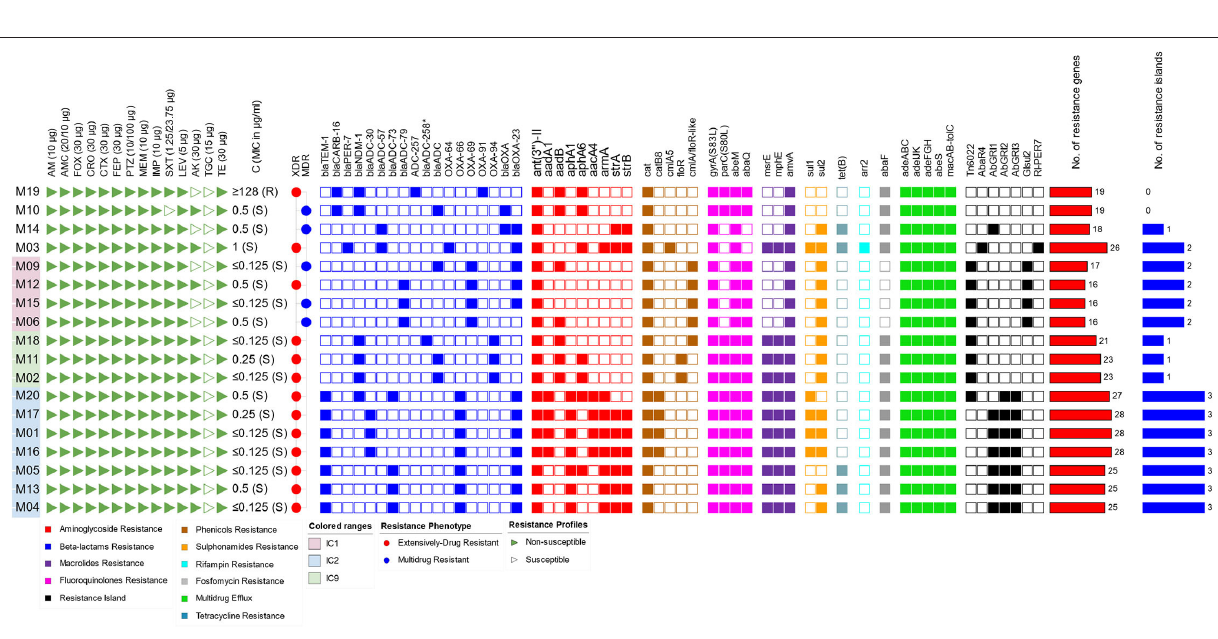
FIGURE 2 | Overview of the antimicrobial susceptibility profiles and resistance determinants. The isolates were ordered according to their SNP-based phylogenetic relationship. Labels of GC1 isolates (together with their phylogenetically related isolates) are highlighted in pink and those of GC2 and GC9 are highlighted in blue and green, respectively. The map is divided into panels corresponding to susceptibility to antimicrobial agents (triangular icons), resistance phenotypes (circular icons), resistance determinants (square icons), and the number of resistance determinants and islands (bars). AM, ampicillin; AMC, amoxicillin/clavulanic acid; FOX, cefoxitin; CRO, ceftriaxone; CTX, cefotaxime; FEP, cefepime; PTZ, piperacillin/tazobactam; MEM, meropenem; IMP, imipenem; SXT, sulfamethoxazole/trimethoprim; LEV, levofloxacin; AK, amikacin; TGC, tigecycline; TE, tetracycline; C, colistin; XDR, extensive drug resistance; MDR, multidrug resistance. were identified, including a novel variant ( bla ADC − 258 ) carried genes, encompassing bla TEM − 1 , bla CARB − 16 , bla NDM − 1 , bla PER − 7 , by M18. bla ADC − 258 showed 99.74% similarity to bla ADC − 176 and bla OXA − 23, were identified. Up to five β -lactamase coding with the amino acid alterations Q2R and D24G. genes co-existed in the tested isolates. At least six bla ADC variants